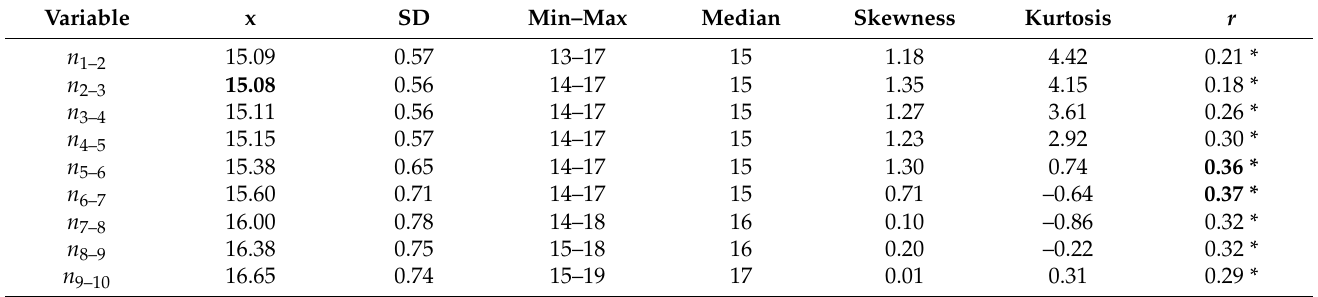
Table 4. Descriptive statistics of basic and addition spatial variables (IHU) in the entire group of athletes.